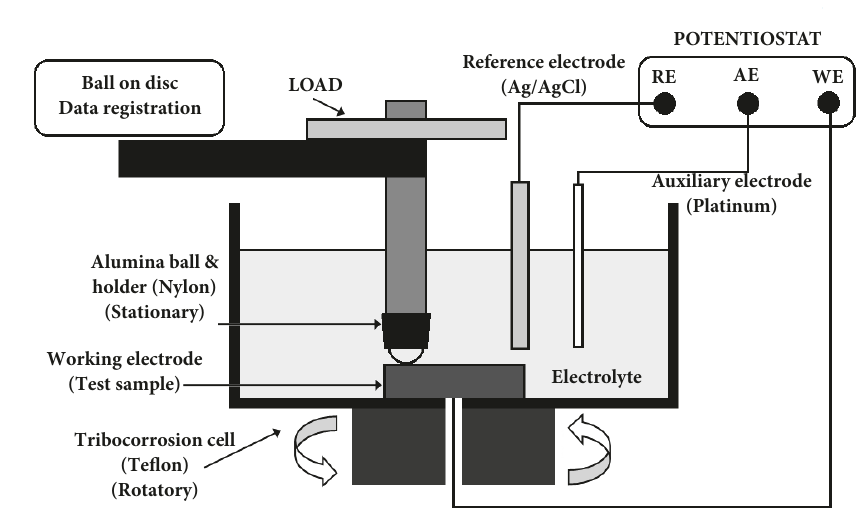
Figure 1: Schematic of a unidirectional tribocorrosion ball-on-disc experimental